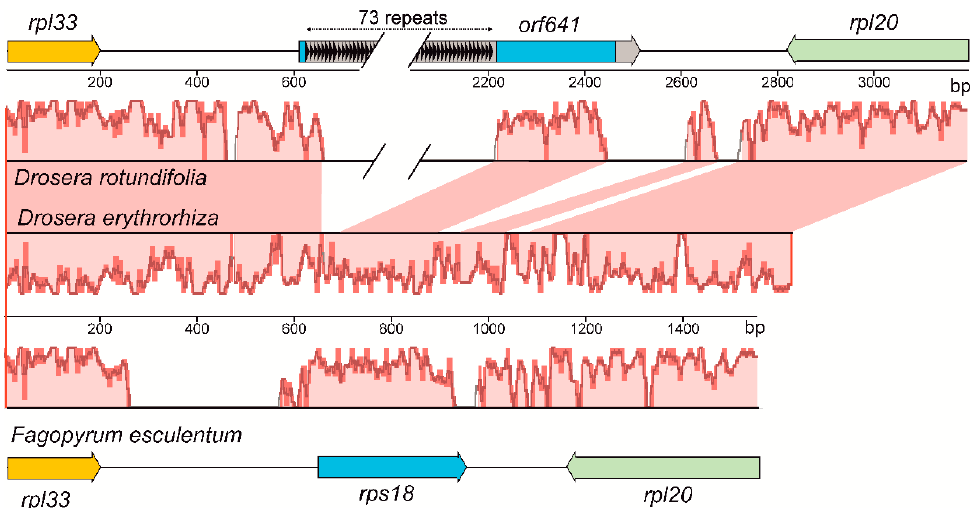
Figure 2. Comparison of the plastid genome regions comprising genes rpl33 , rps18 , and rpl20 for D. rotundifolia , D. erythrorhiza , and F. esculentum . Regions between the start of rpl33 and the start of the counter-oriented rpl20 are shown; coordinate numbering for each plastome starts from the beginning of gene rpl33 . Genes are indicated by rectangles with arrowheads. Black triangles within the orf641 rectangle indicate 73 copies of the 21 bp-long repeat sequence coding for a peptide with GQKQPNI consensus in D. rotundifolia . The part of orf641 that corresponds to the rps18 sequence is indicated in blue. The central part shows alignment in Mauve; pink areas between D. rotundifolia and D. erythrorhiza sequences highlight homologous regions. Note that the Mauve profile obtained for D. erythrorhiza has been turned upside down for clarity of presentation.